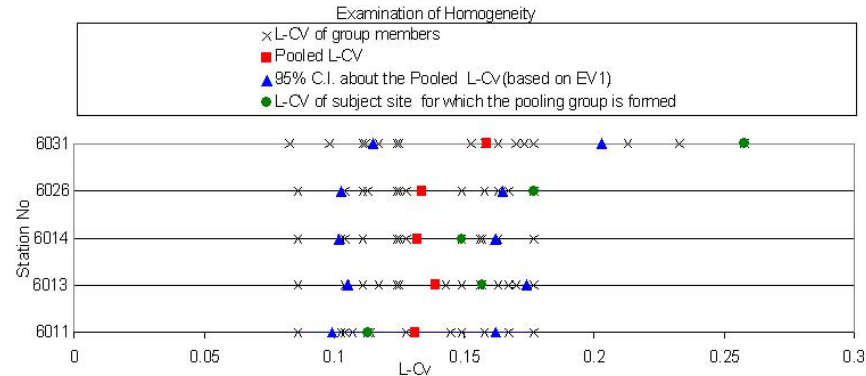
Fig. 3. Examination of homogeneity (EV1 case).